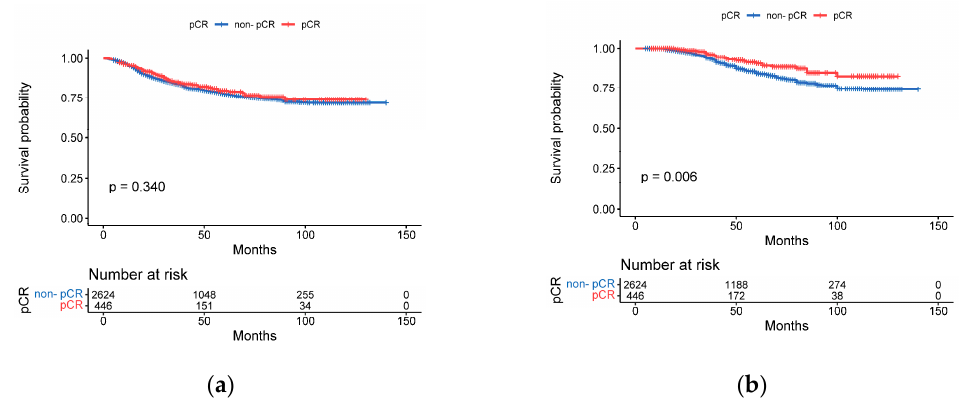
Figure 2. Kaplan ‒ Meier curves for disease-free survival (DFS) and overall survival (OS) by pCR. ( a ) Figure 2. Kaplan–Meier curves for disease-free survival (DFS) and overall survival (OS) by pCR. DFS for non-pCR vs. pCR ( b ) OS for non-pCR vs. pCR. ( a ) DFS for non-pCR vs. pCR ( b ) OS for non-pCR vs.